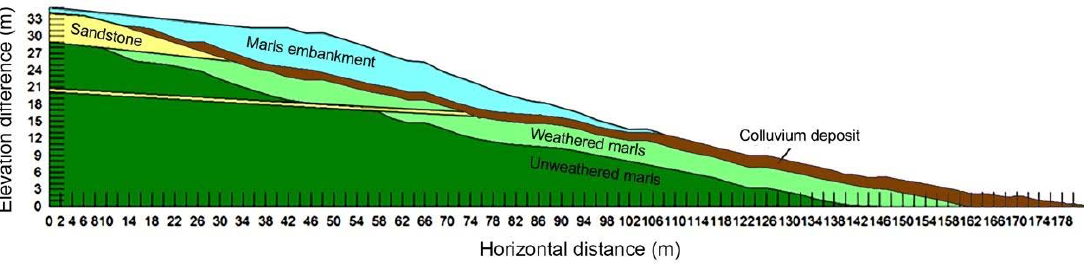
Figure 9. Geological model of the Cachoeiras area profile.